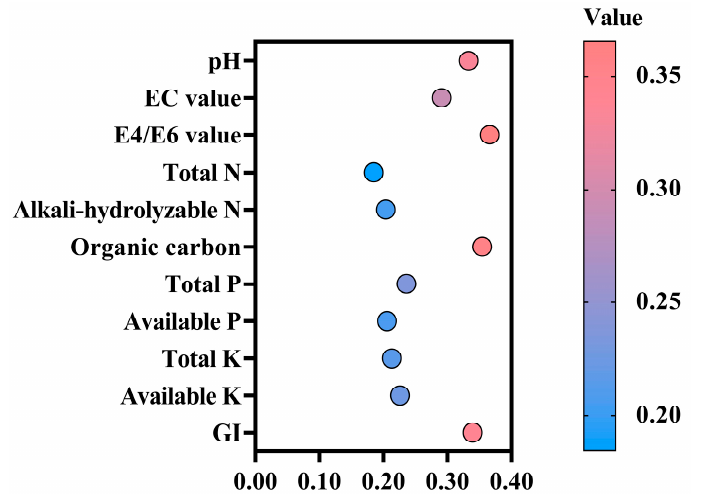
Figure 11. Gray analysis of C/N and other indicators.